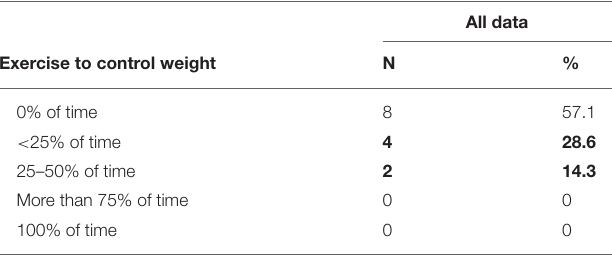
TABLE 4 | Eating disorder pathogenic behaviors among recreational endurance-trained male athletes ( n = 14).